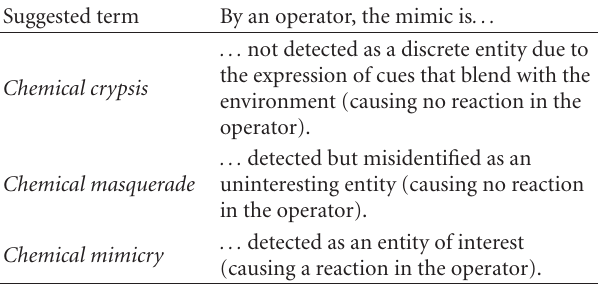
Table 3: Proposed terminology for chemical adaptive resemblances. Chemical cues of a mimic can either be “ acquired ” from the environment (including the host), or they can be “ innate ”, that is, biosynthesized. In all cases of chemical adaptive resemblance, the operator is deceived by the mimic so that the mimic